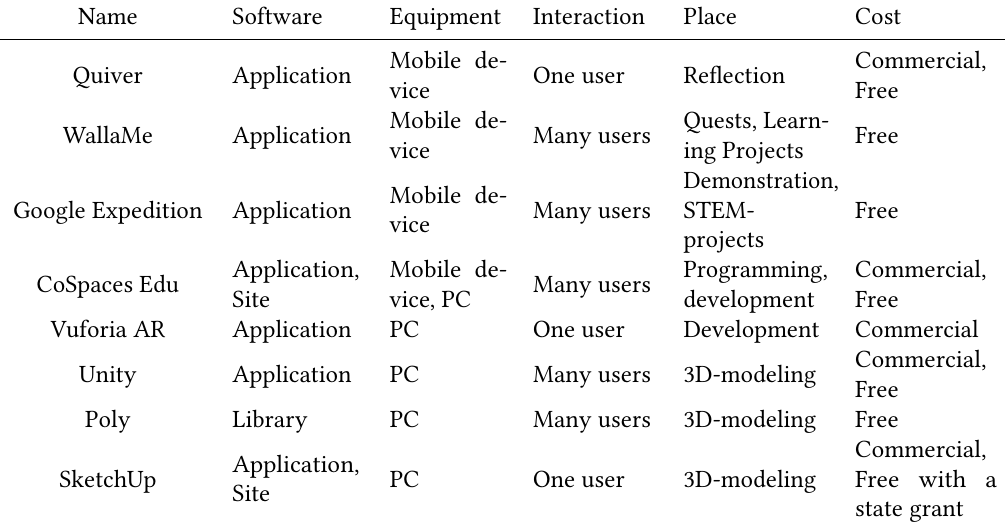
Table 1 Augmented reality program